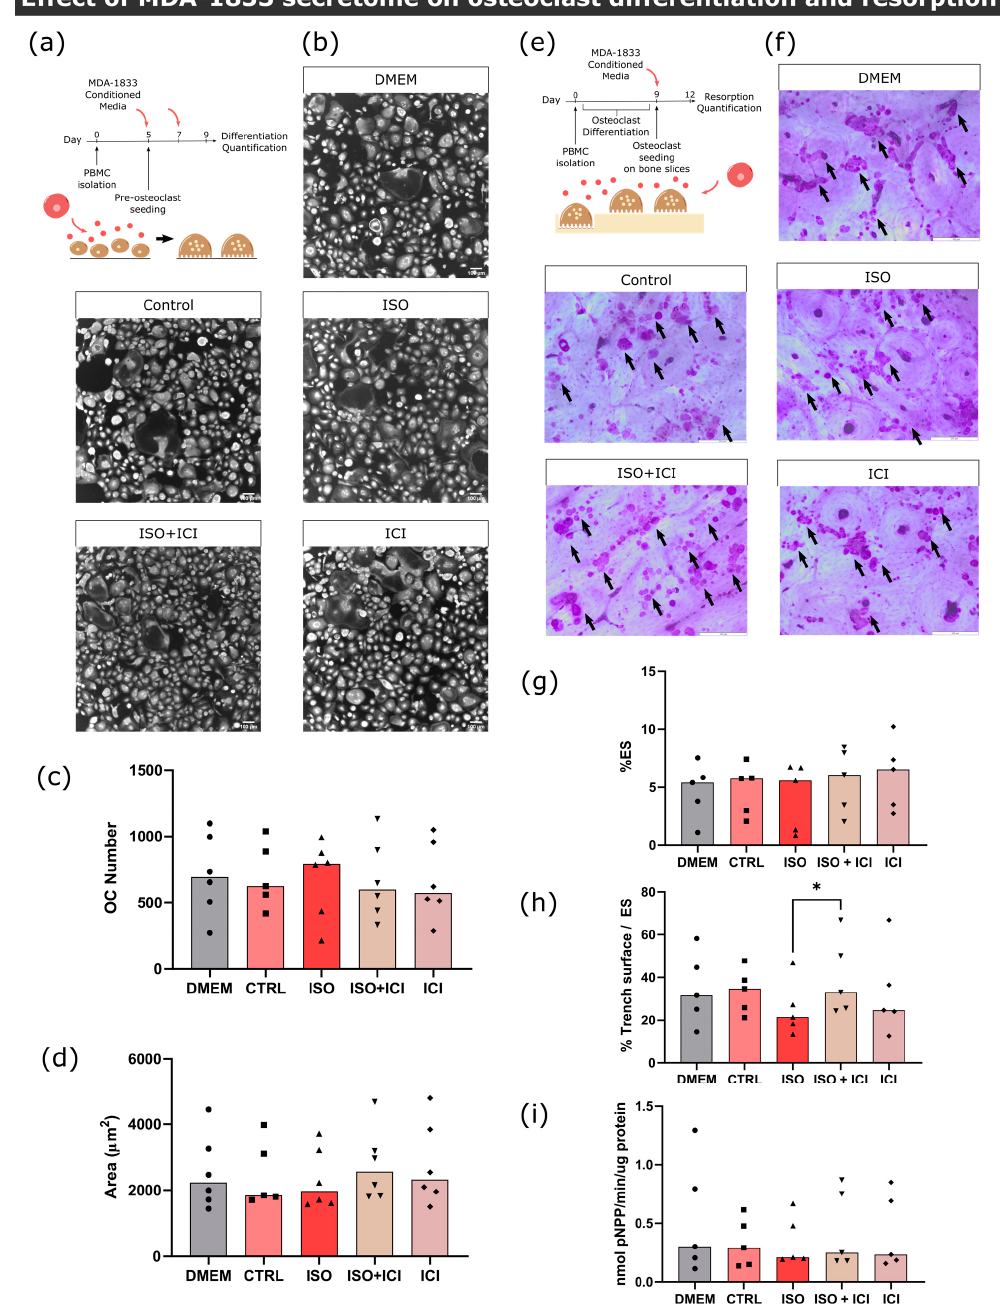
Figure 5. Effect of MDA-1833-conditioned medium on osteoclast differentiation and resorption activity. ( a ) Timeline of the osteoclast differentiation assay. Pre-osteoclasts are seeded after five days of culturing and stimulated with the MDA-1833 cell secretome for four more days, refreshing the